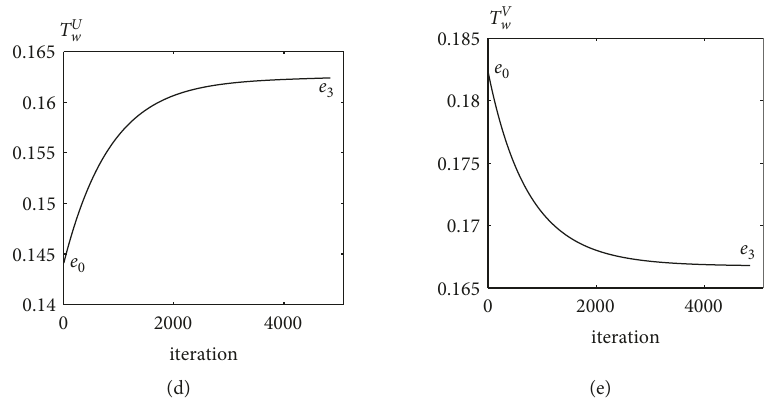
Figure 12: Equilibrium transition when Q V � 5 . 0 × 10 4 /hr. (a) Transition path θ U � 1 , θ V � ( 1/6 ) . (b) Transition path ( θ U � 1 , θ V � ( 1/6 . 6702 )) . (c) Transition path ( θ U � 1 , θ V � ( 1/8 )) . (d) Evolution of T U ( θ U � 1 , θ V � ( 1/6 . 6702 )) . T V w